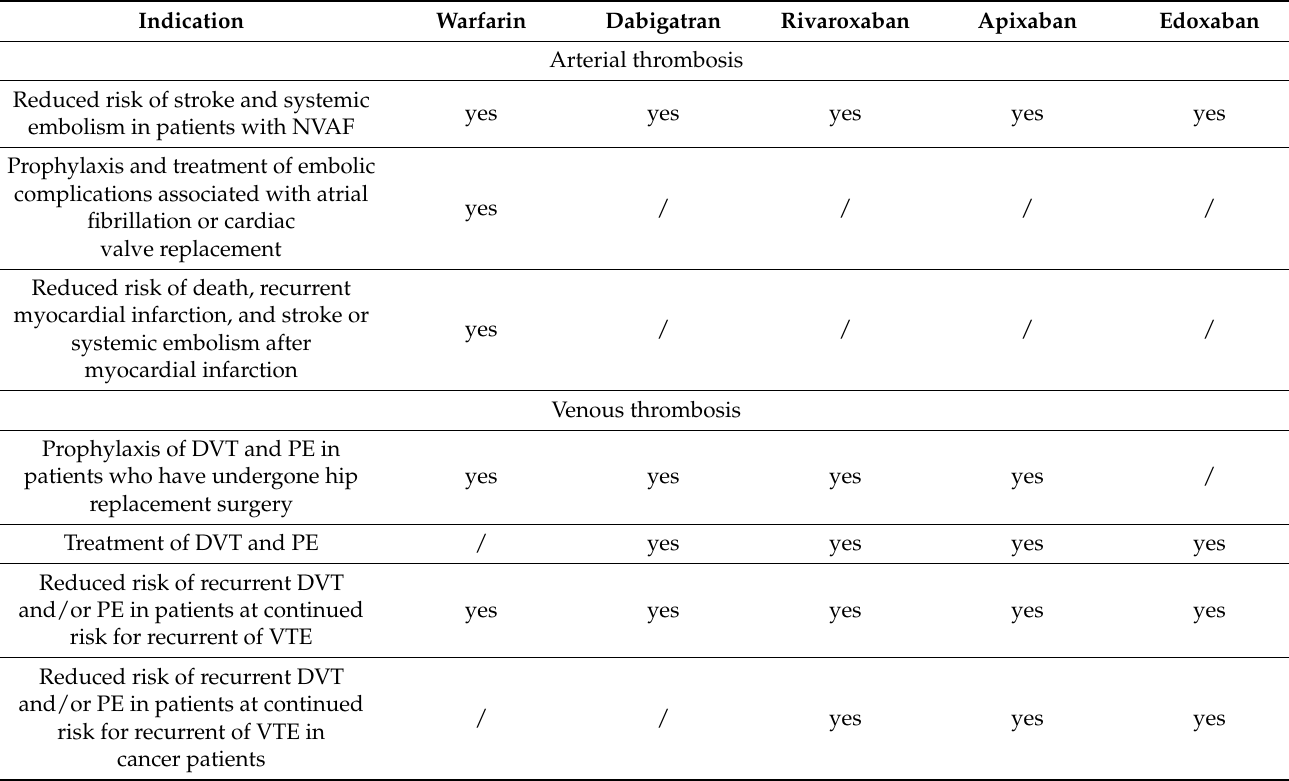
Table 6. Indications for the orally administered anticoagulants warfarin, dabigatran, rivaroxaban, apixaban, and